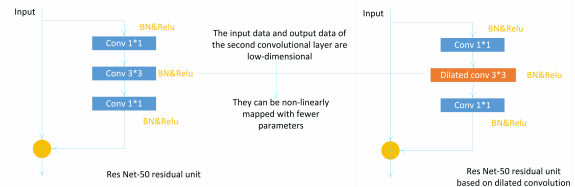
Fig. 4. Sight tracking model based on classification input of the gaze tracking model based on